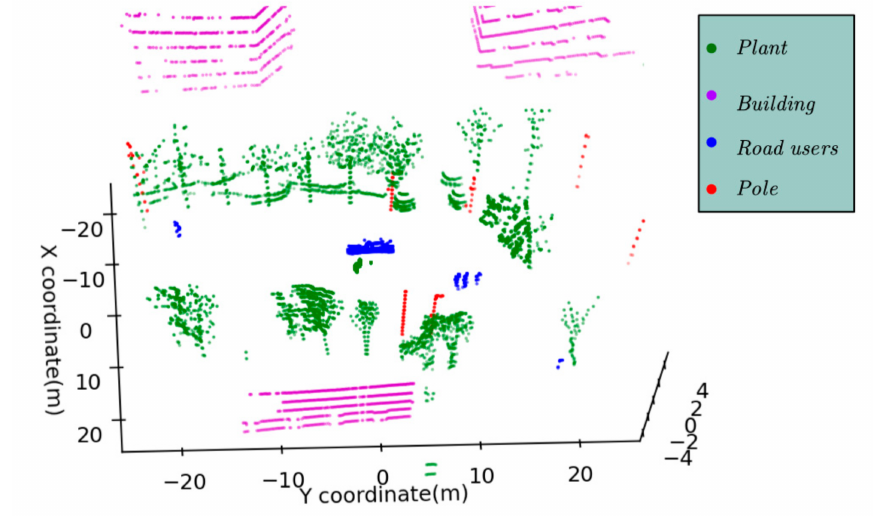
Figure 18. The results of semantic segmentation, where green objects belong to plants, violet objects belong to buildings, blue objects belong to the road users, and the red objects belong to